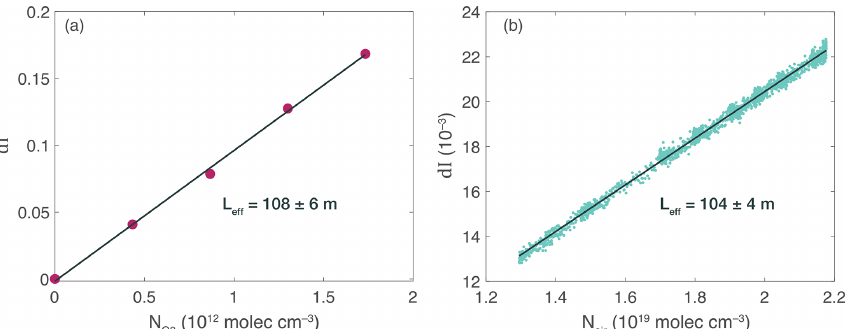
Figure 4. ROZE calibration. (a) The effective pathlength ( L eff ) as determined by attenuation (d l ) due to known additions of O 3 from a commercial ozone generator. The slope yields the effective pathlength as determined from Eq. (1) in the text using the known O 3 absorption cross section. (b) Attenuation due to Rayleigh scatter over a range of cell pressures. The slope of attenuation as a function of number density gives the pathlength using the known Rayleigh scattering cross section for zero air. The pathlength derived from both calibrations agree to within the 2 σ fit uncertainty.